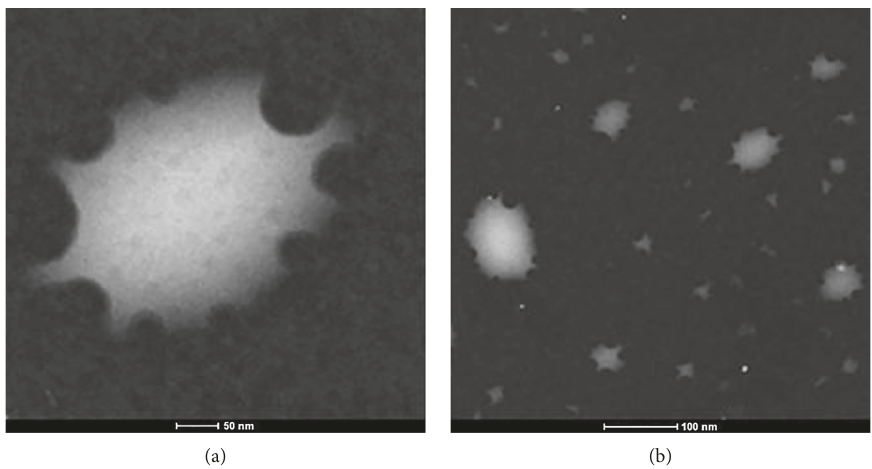
Figure 12: STEM images for MnTTPCl/n-Au hybrid treated with β